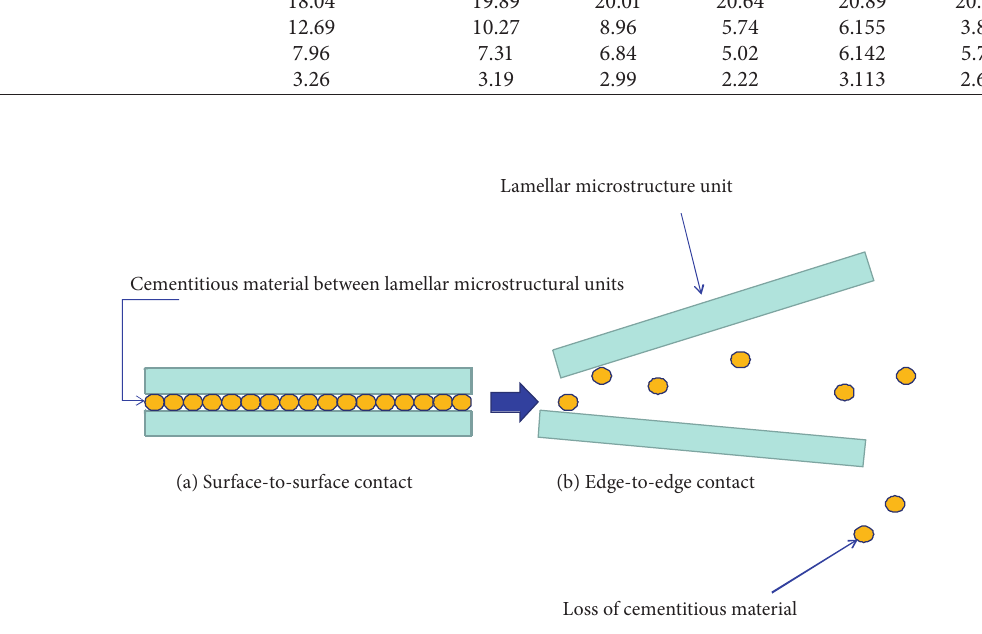
Figure 11: Structure model of lamellar microstructure unit of Baise expansive